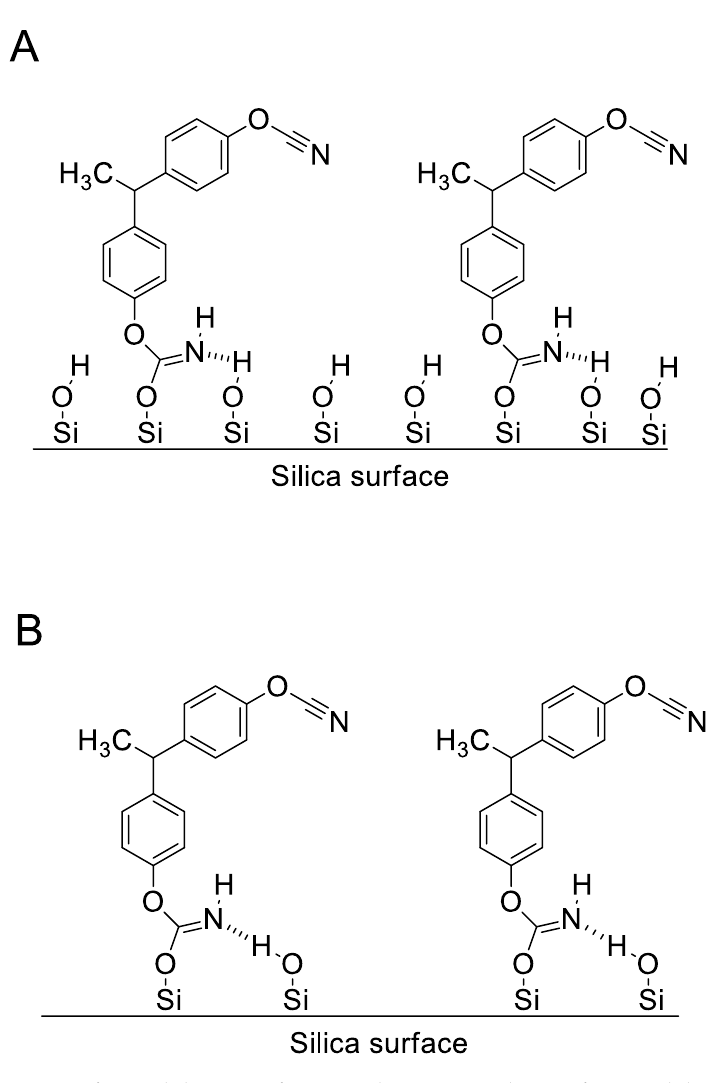
Figure 15. Illustration of immobilization of iminocarbonates on silica surfaces with high ( A ) and low ( B ) concentration of silanols.